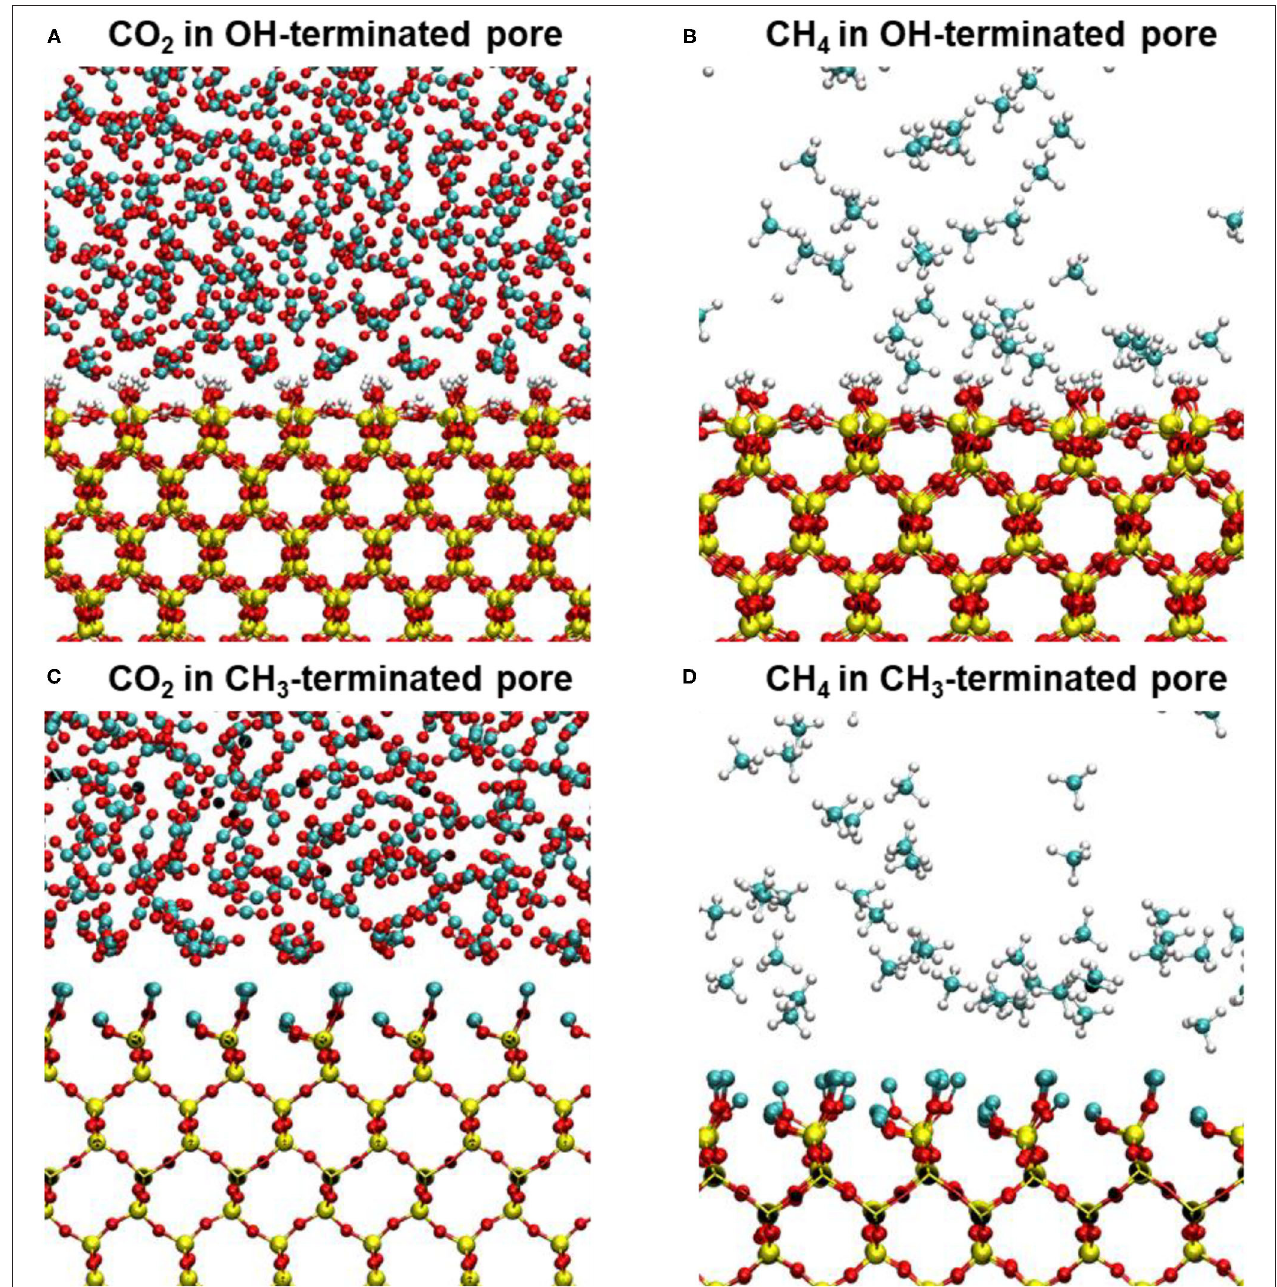
FIGURE 5 | Snapshots showing the interfacial CO 2 and CH 4 molecules on (A,B) OH-terminated pore surfaces and (C,D) CH 3 -terminated pore surfaces. The snapshots represent the last trajectory frame of CO 2 and CH 4 molecules confined in 10nm pores. The exclusion regions of interfacial CO 2 molecules on CH 3 -terminated pores are evident in panels (C,D)